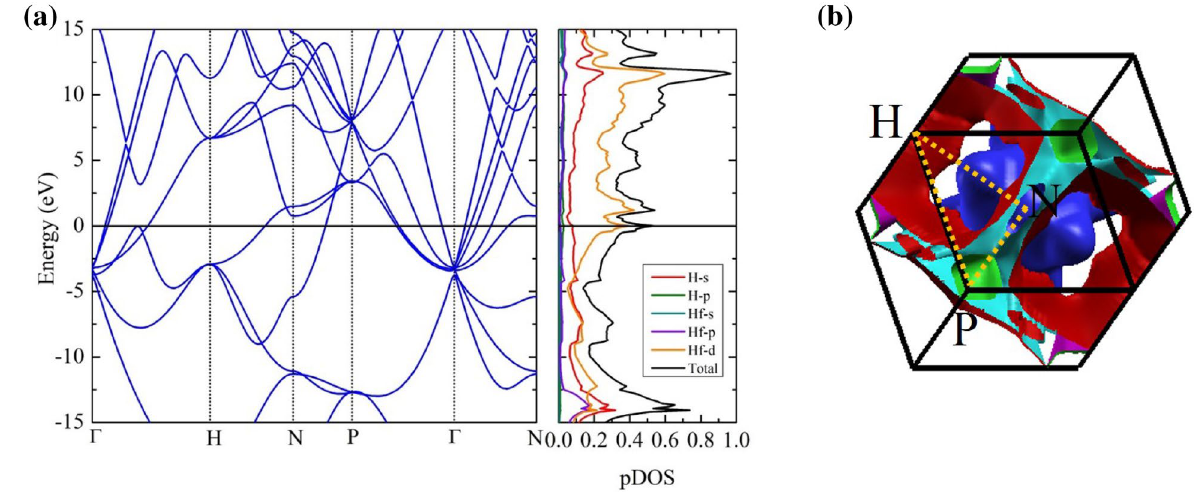
Figure 2. ( a ) The calculated electronic band structure and projected density of states of the sodalite-like clathrate hafnium hexahydride structure at 600 GPa. ( b ) Fermi surfaces of the sodalite-like clathrate hafnium hexahydride structure at 600 GPa. (drawn by XCrySDen program (ver. 1.5.60) 52 (URL http:// www. xcrys den. org/ Downl oad. html#_ toc_1)).